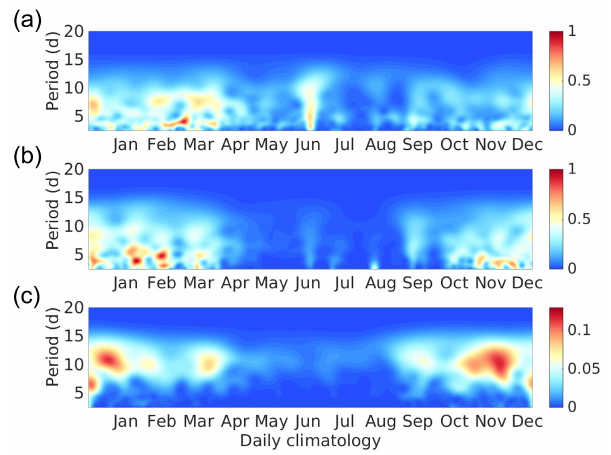
Figure 12. Wavelet power spectrum for time series averaged over the western 50m isobath of (a) cross-shelf total nitrogen flux ver- tically integrated (TN, mmolNm − 1 s − 1 ), (b) along-shelf wind stress ( τ along , Nm − 2 ), and (c) sea level anomaly (SLA, m). The temporal series are detrended, normalized, and filtered by a Lanc- zos high-pass filter with a cut-off of 15d.